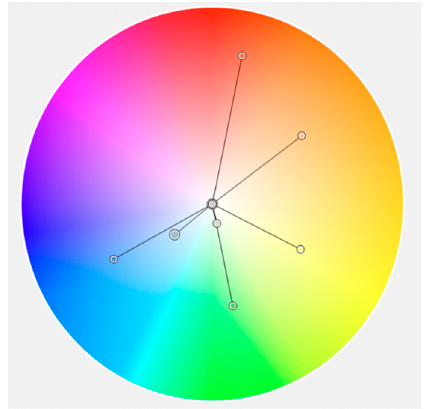
Figure 15. The Wikimapia color analysis.